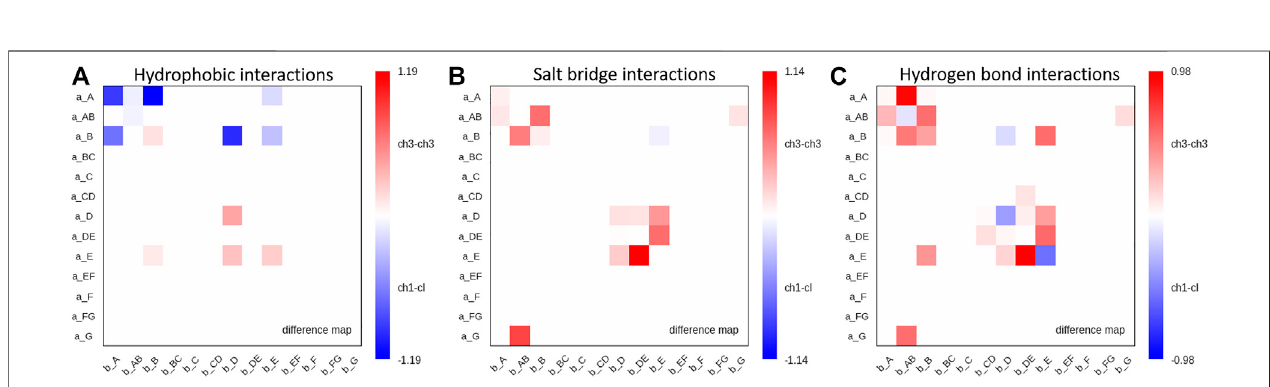
FIGURE 6 | Maps depicting the differences in hydrophobic interactions, salt bridges and hydrogen bonds between C H 3-C H 3 and C H 1-C L domains. (A) Difference in hydrophobic interactions between all investigated C H 3-C H 3 and C H 1-C L domains ( Supplementary Table S1 ) based on the previously de fi ned coarse graining of the residues belonging to the same loops or β -strands. We normalized the colorbar according to the most frequent contact in either of the two interface classes. (B) Difference in salt bridge interactions between all investigated C H 3-C H 3 and C H 1-C L interfaces, showing the substantially higher number of salt bridge interactions dominating the C H 3-C H 3 interface. (C) Hydrogen bond difference maps for all investigated C H 3-C H 3 and C H 1-C L interfaces.